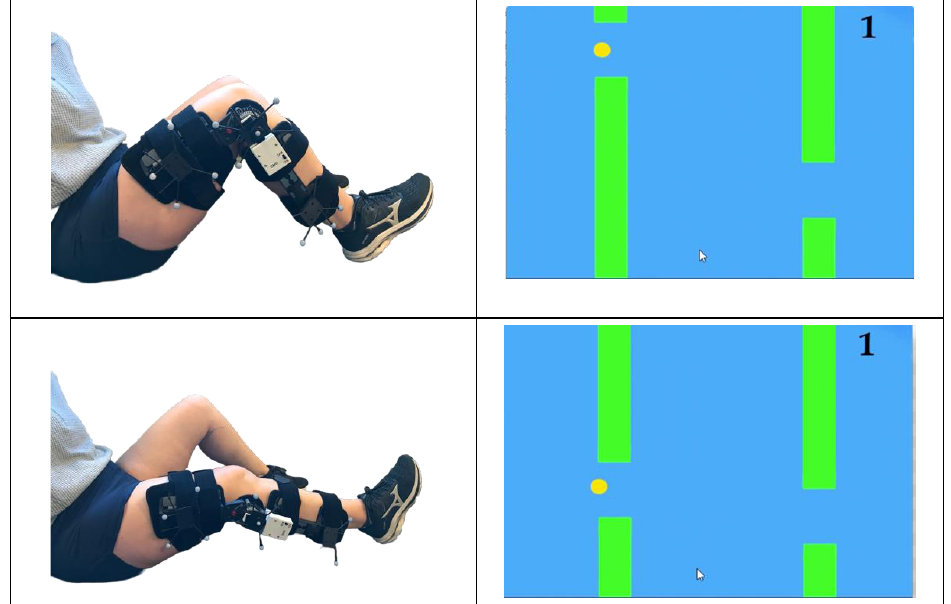
Figure 3. Exergame set up. Yellow ball onscreen is controlled by knee motion (flexion/extension) while wearing the instrumented knee brace. The ball moves across the screen at a constant pace and players flex/extend their knee to move the ball up and down to avoid the obstacles. For each obstacle that is avoided, players earn a point. The score is displayed in upper right-hand corner.